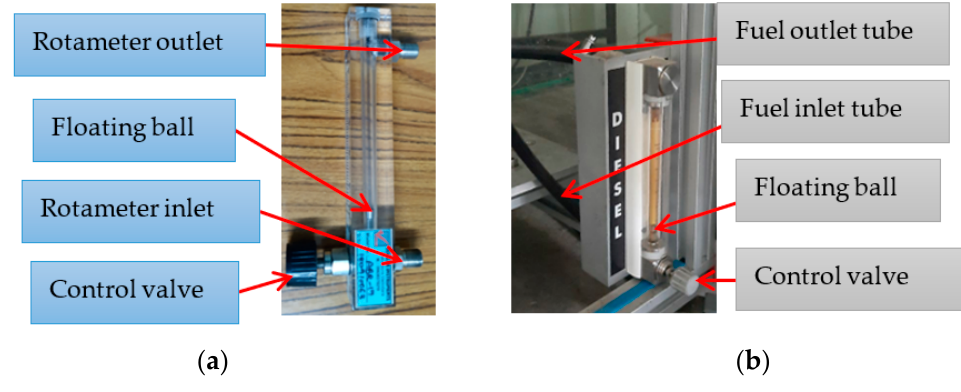
Figure 2. Flowmeters. ( a ) Rotameter, ( b ) burette. Table 4. Baseline data experimental test matrix.